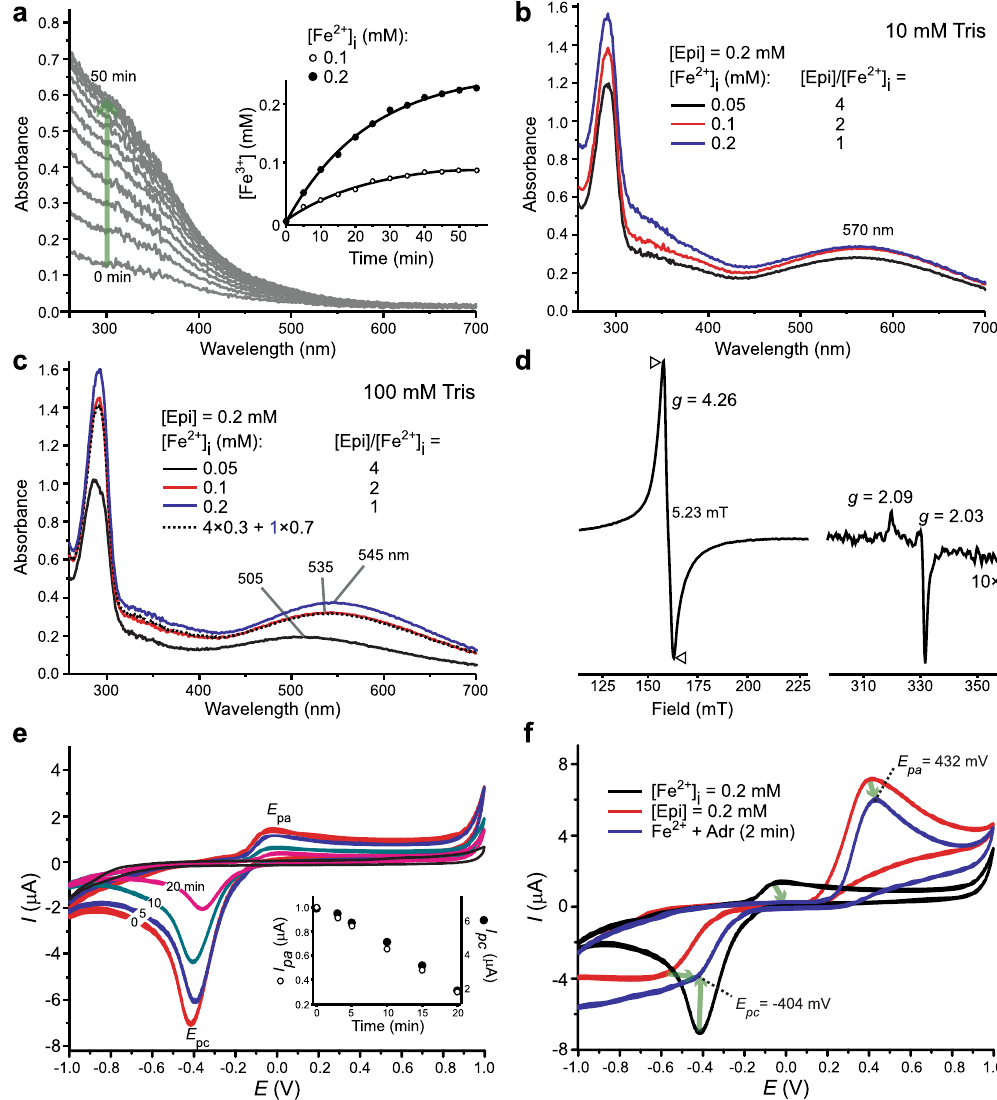
Figure 5. Redox interactions of 0.2 mM Epi with Fe 2 + at pH 7.4. ( a ) UV/Vis spectra showing the oxidation of 0.2 mM Fe 2 + to Fe 3 + in 10 mM Tris. Inset: The accumulation of Fe 3 + during spontaneous oxidation of 0.1 and 0.2 mM Fe 2 + ; [Fe 3 + ] was calculated using the absorbance at 300 nm and the FeCl 3 calibration curve. Exponential fits are presented ( R 2 > 0.990). ( b ) UV/Vis spectra of Epi/Fe 2 + systems after 1 min incubation in 10 mM Tris. ( c ) UV/Vis spectra of Epi/Fe 2 + systems after 1 min incubation in 100 mM Tris. Dashed line represents the sum of experimental spectra. ( d ) 20 K EPR spectrum of the [Epi]/[Fe 2 + ] i = 2 system in 10 mM Tris after 1 min of incubation. The high field part of the spectrum was multiplied 10 × for clarity (right). ( e ) Time-dependent changes of CV and peak currents ( I pa and I pc ) of [Fe 2 + ] i = 0.2 mM in 10 mM Tris at boron doped diamond electrode. Black line – CV of Fe 3 + (0.2 mM). ( f ) Changes (marked with arrows) of anodic and cathodic E and I of Fe 2 + and Epi in the [Epi]/[Fe 2 + ] i = 2